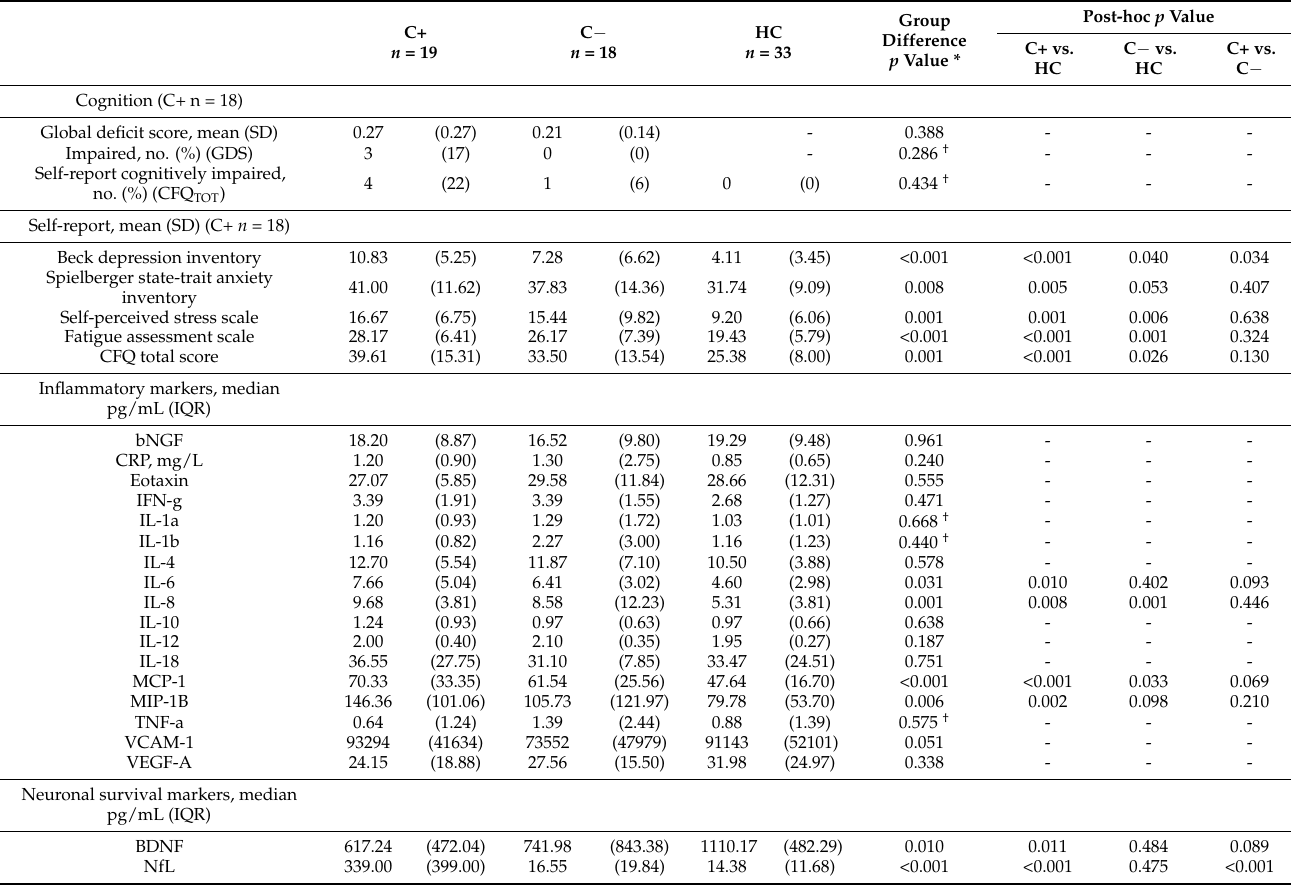
Table 2. Neuropsychological assessment, questionnaires and blood